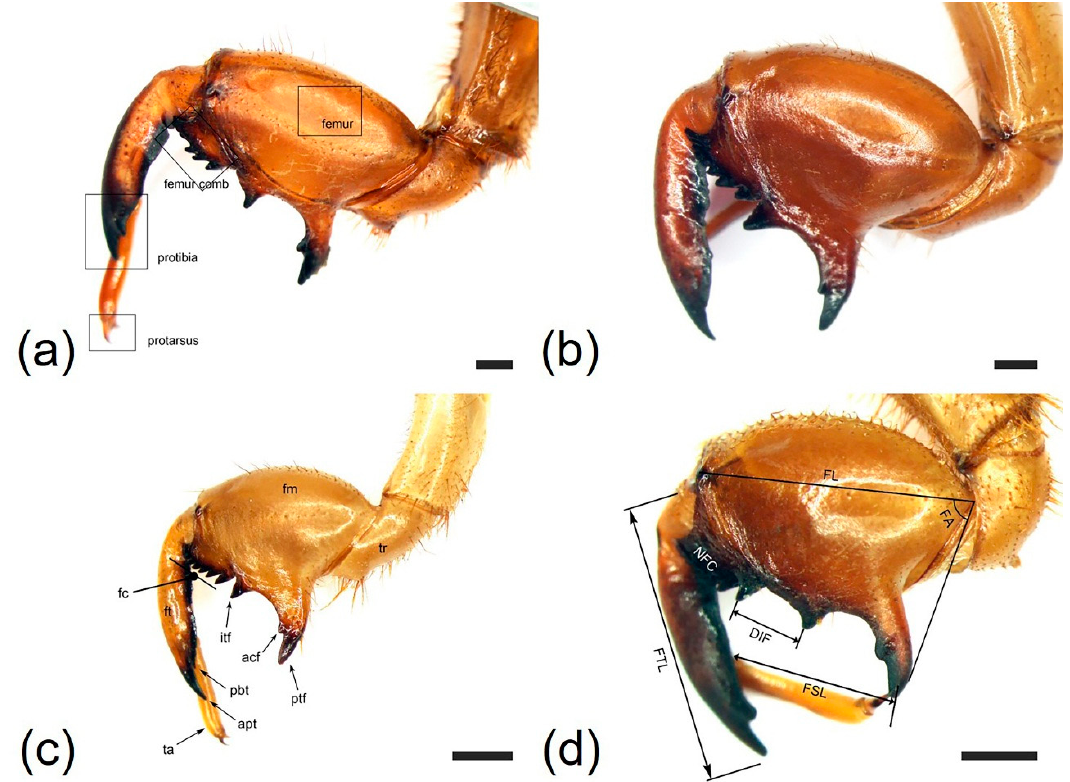
Figure 1. Morphological characteristics of the fore-legs of the four species, showing the measurements: ( a ) Cryptotympana atrata ; ( b ) Hyalessa maculaticollis ; ( c ) Meimuna opalifera ; ( d ) Platypleura kaempferi . Open squares correspond to those of ultrastructural characteristics. acf, accessory tooth of femur; apt, apical tooth of tibia; fc, femoral comb; fm, femur; ft, tibia; itf, intermediate tooth of the femur; pbt, point of blade of tibia; ptf, posterior tooth of the femur; ta, tarsus; tr, trochanter; DIF, distance between the intermediate tooth of the femur and last tooth of the femoral comb; FA, femoral tooth angle; FL, profemur length; FSL, pretarsus length; FTL, protibia length; number of femoral comb teeth. All scale bars = 1.0 mm.